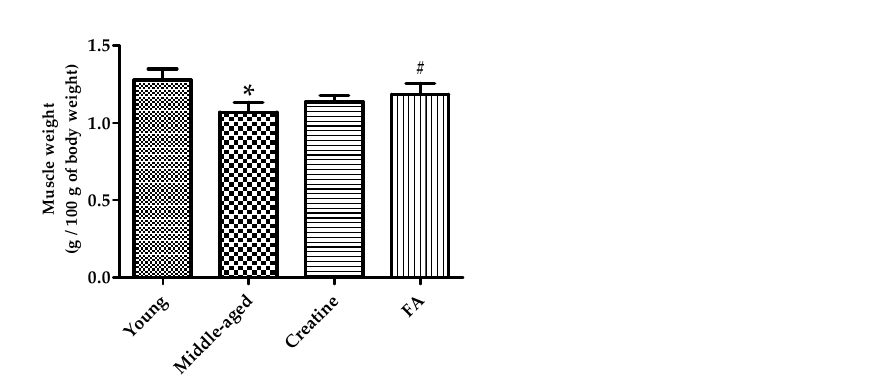
Figure 3. Relative weight of muscle (gastrocnemius + soleus) to body weight. Data are expressed as the mean ± SD ( n = 5 mice per group), and p -values < 0.05 (*) as compared with the young control or p -values < 0.05 (#) as compared with the middle-aged control mice.